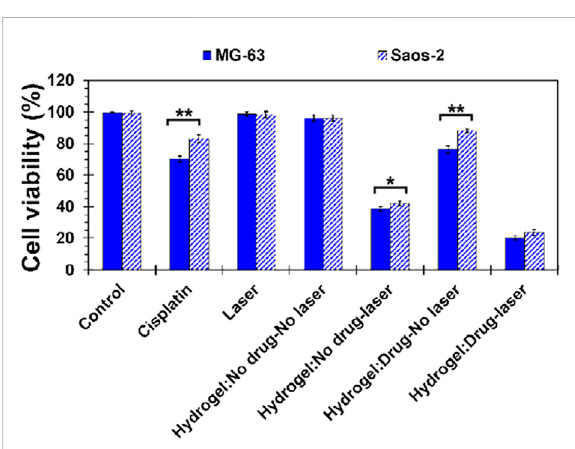
FIGURE 6 Behavior of MS2 hydrogels against osteosarcoma cell lines (Saos-2 and MG-63) by MTT assay after 48 h culturing the cells. [Difference is considered to be statistically ( p ≤ 0.05*) and very statistically ( p ≤ 0.005**) signi fi